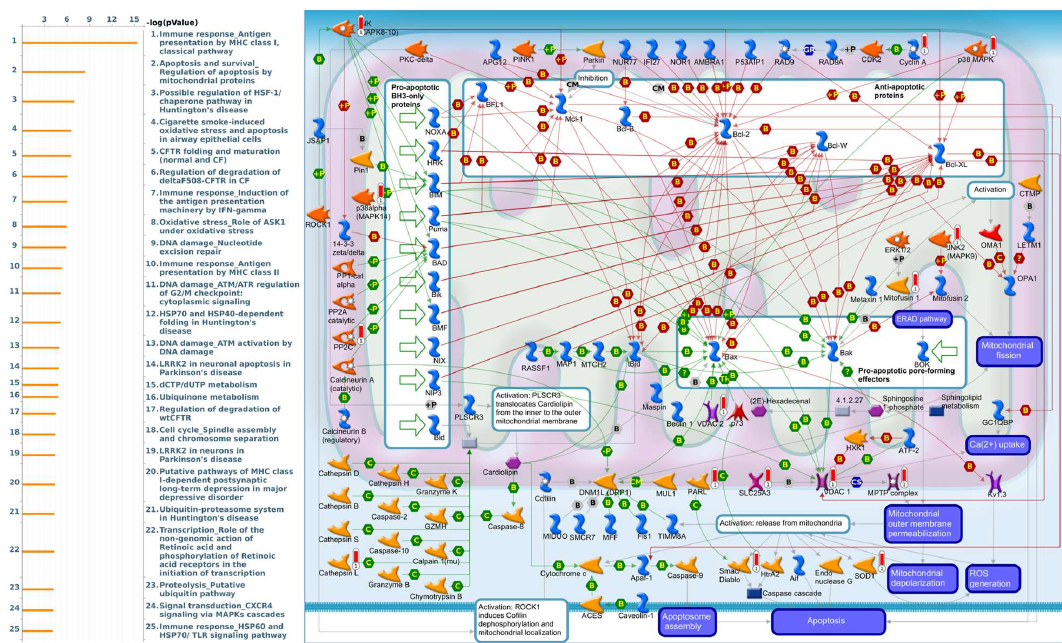
Figure 9. MetaCore pathway analysis of the coexpression gene network of proteasome 20S subunit alpha 5 (PSMA5) in breast cancer patients. We used the MetaCore platform to analyze genes coexpressed with PSMA5 from the associated METABRIC and TCGA datasets, and downstream pathway analyses revealed that “Cell cycle_The metaphase checkpoint” participates in breast cancer development.